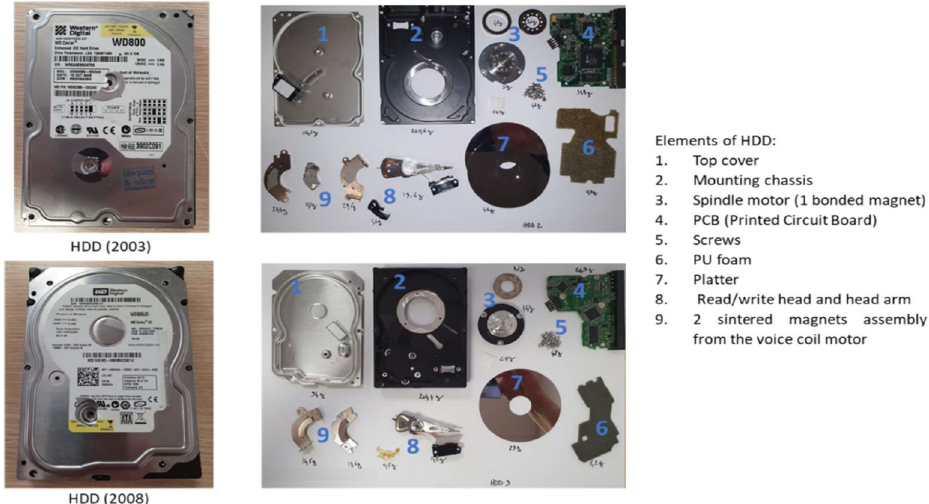
Figure 4. The 3.5” HDDs and disassembled components.